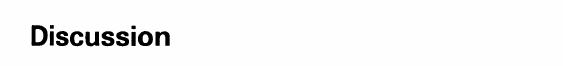
FIG. 1. Carrageenin-induced paw oedema formation in rats fed with control (), soybean (- -) or fish oil-rich diets.